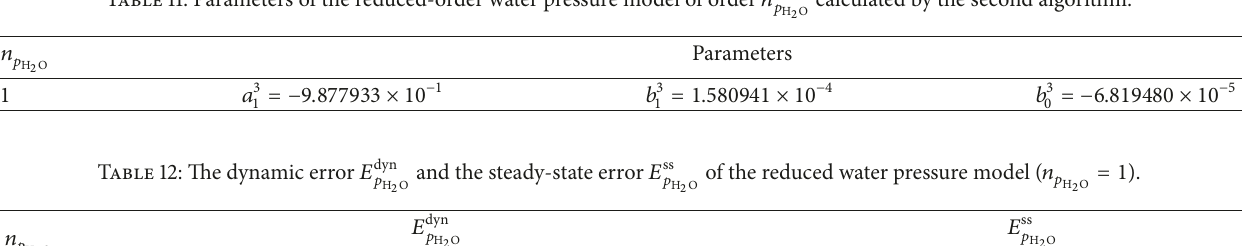
calculated by the second algorithm. H 2 O